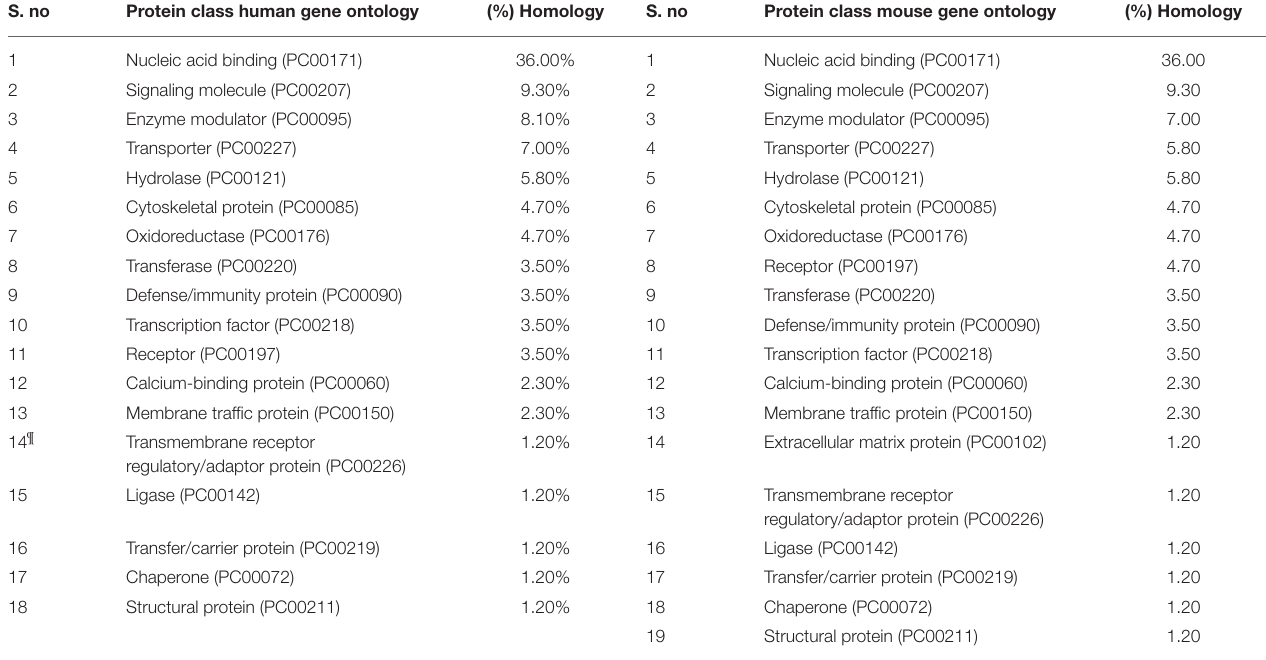
Column 14 ¶ No match for protein class between mouse and human gene